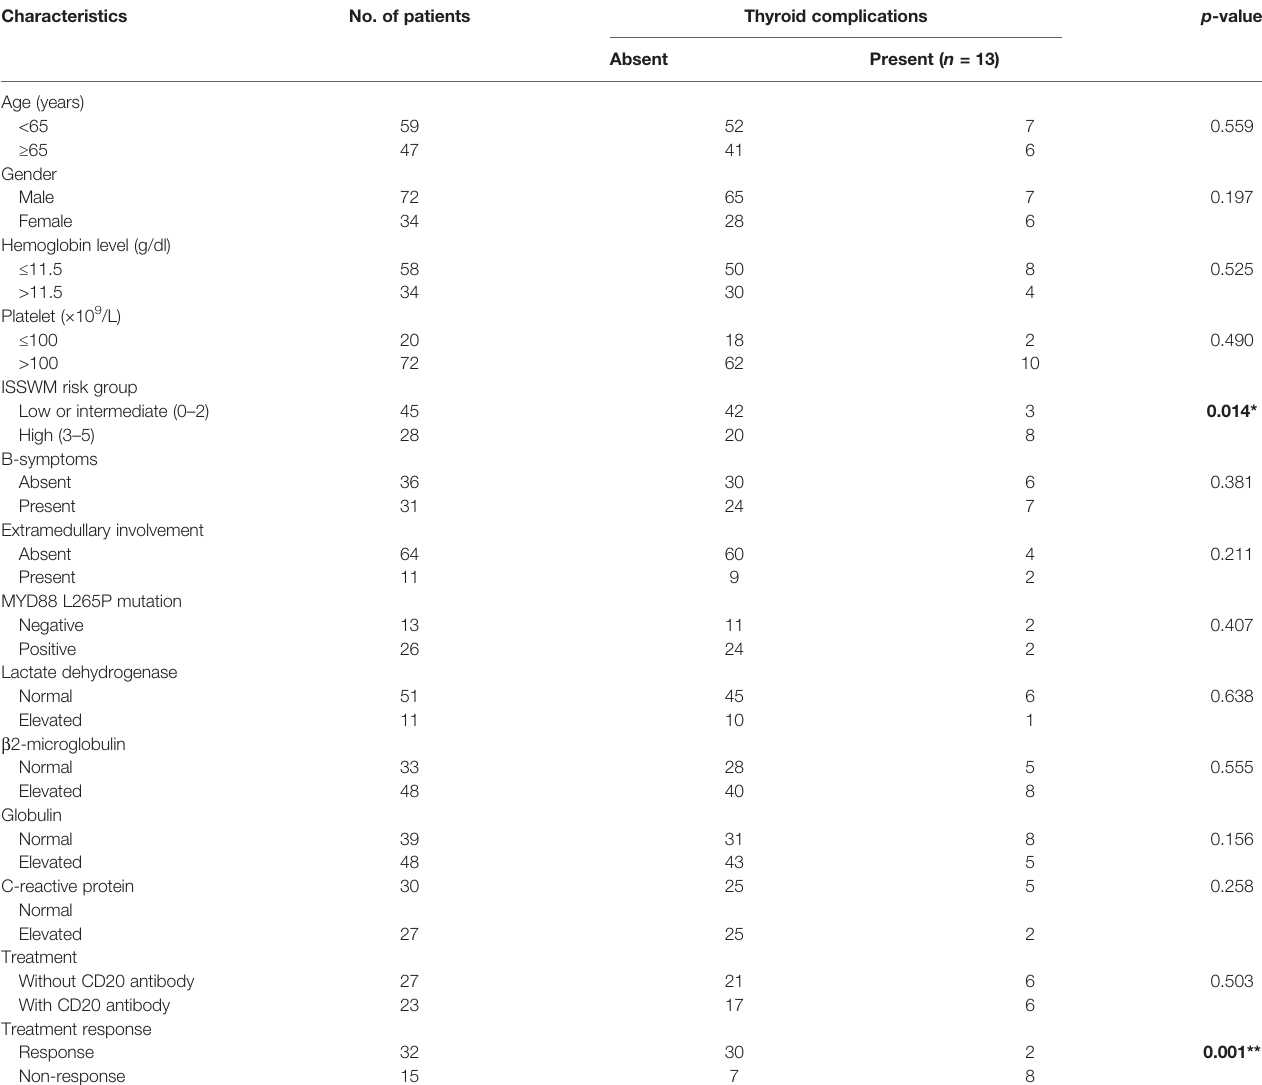
TABLE 3 | Comparative clinical and biological characteristics of WM/LPL with or without thyroid complications.